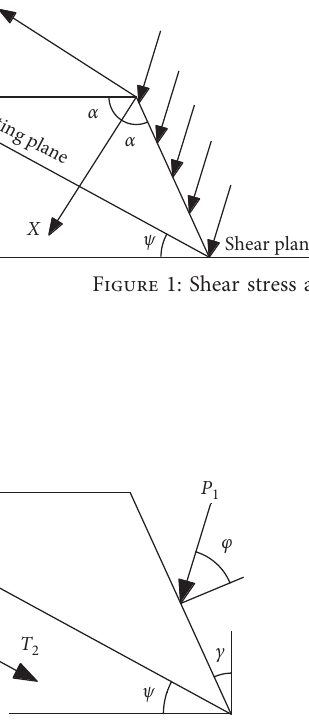
Figure 2: Shear body force analysis.